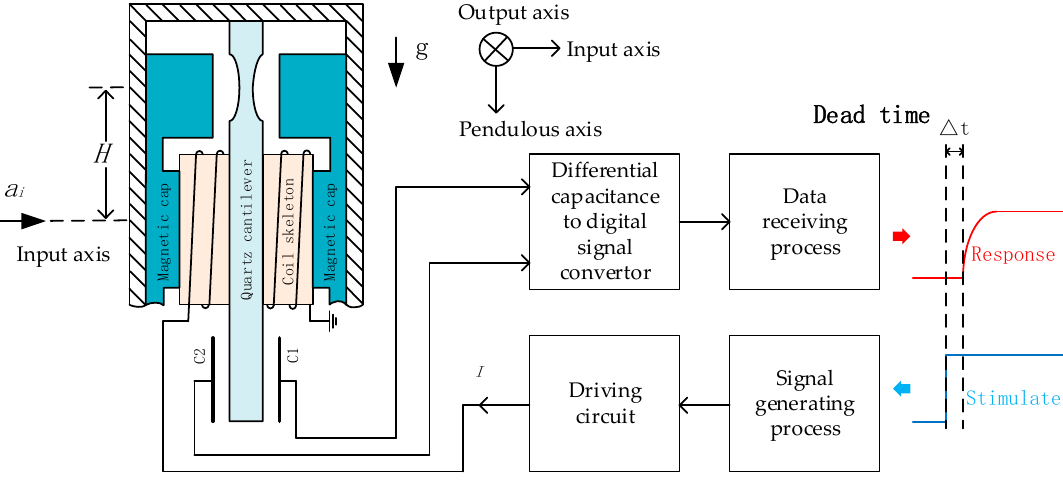
Figure 1. Diagram of the dead time test system.